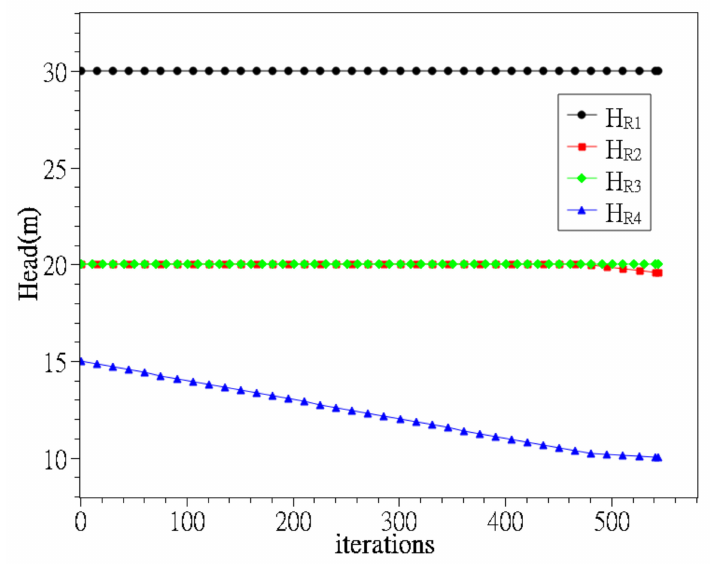
Figure 6. Variation of discharge head for each WTP of the optimization method based on the concept of local search in Case